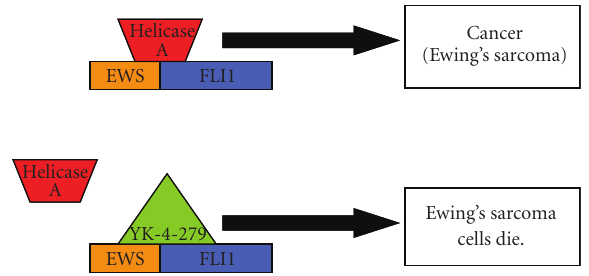
Figure 4: A simplified view of fusion protein: RNA helicase protein disruption, the mechanism of action of a new EWS-FL1 targeted molecule, YK-4-279. Because EWS-FLI1 is a disordered protein that precludes standard structure-based small-molecule inhibitor design, a divergent strategy was designed. EWS-FLI1 interaction with RNA helicase A is critical for oncogenesis. YK-4-279 blocks RHA interaction with EWS-FLI1. This protein–protein inhibition induces apoptosis in EWS cells and reduces the growth of EWS orthotopic